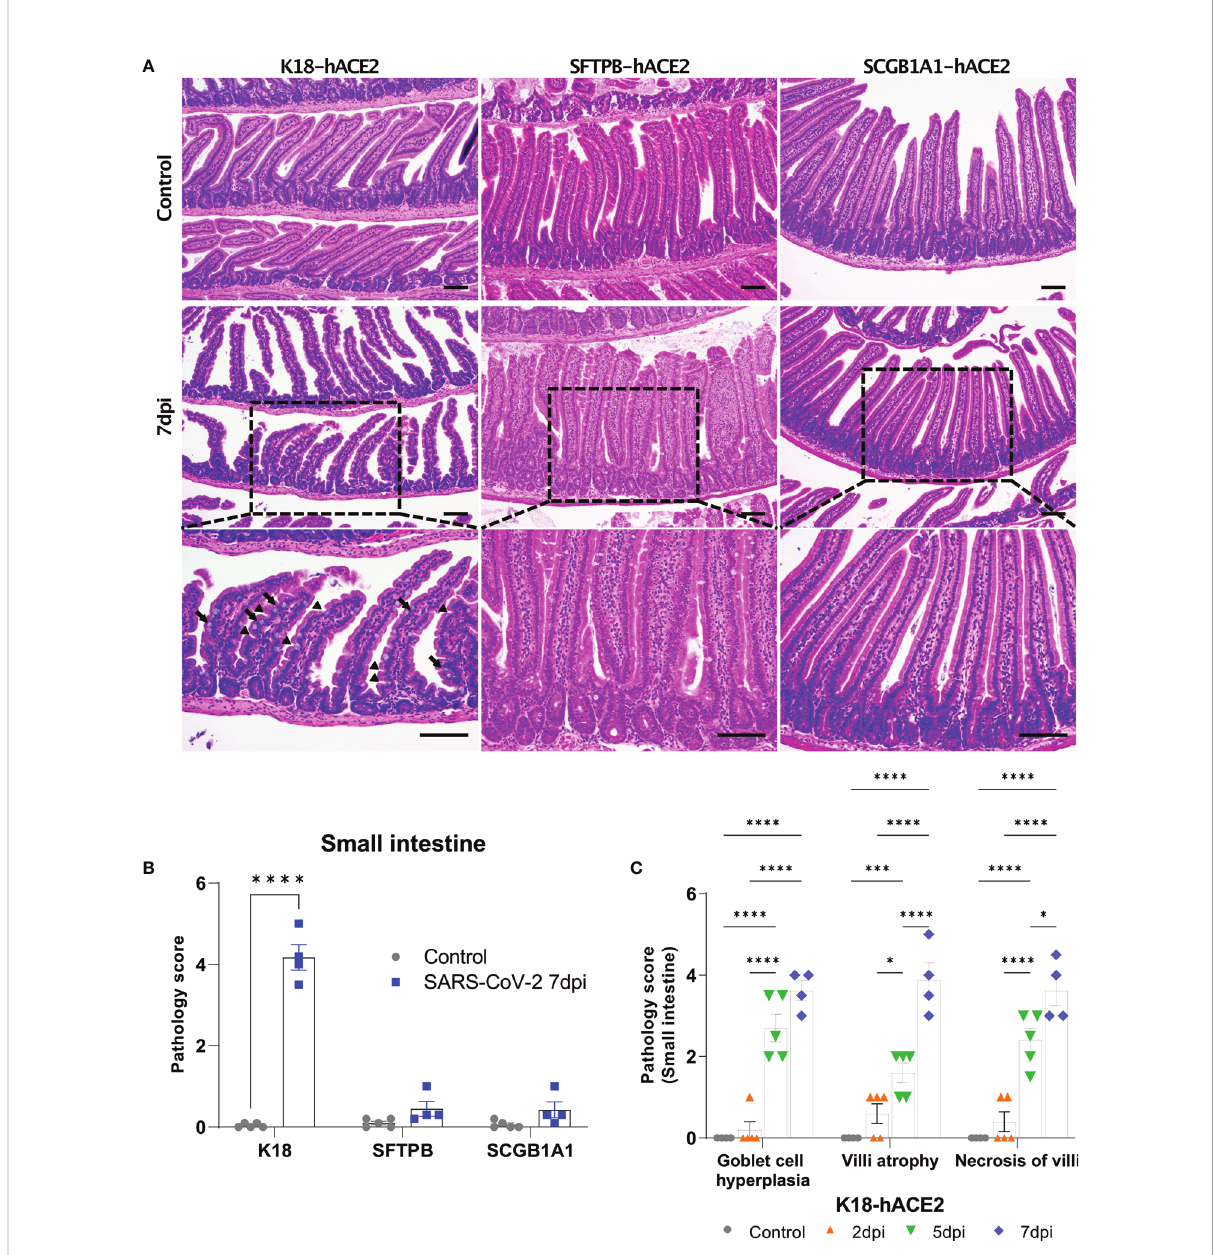
FIGURE 6 Pathological analysis of the small intestine in SARS-CoV-2-infected mice. (A) H&E staining of the small intestine in each mouse model following injection with PBS (control, top panels) or 1 ×10 5 PFU SARS-CoV-2 infection (middle and bottom panels) at 7 dpi. The arrow shows goblet cell hyperplasia and the arrowhead shows villi atrophy. Scale bars =100 m m. (B) Total small intestinal pathology scoring of control and SARS-CoV-2- infected mice at 7 dpi. The severity score ranges from 0 to 5 (0 = none; 1 = weak; 2 = mild; 3 = moderate; 4 = severe; 5; = markedly severe). (C) Pathological scoring by lesion criteria of SARS-CoV-2-infected K18-hACE2 mice. (* P < 0.05; *** P < 0.001; **** P <